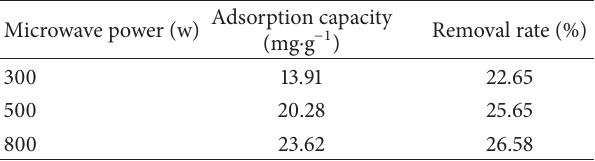
Table 1: Adsorption capacity and removal rate of particle electrodes on MB removal with the effect of microwave